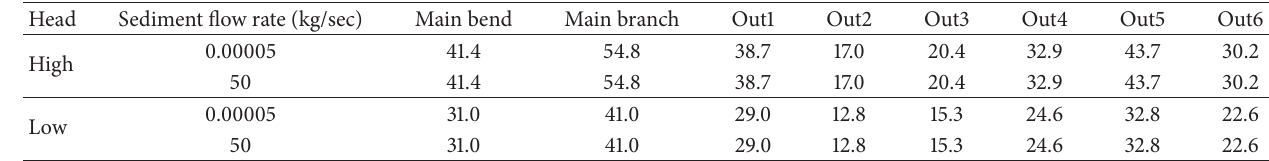
Table 7: Velocity at different locations of Tunnel 2 under different head and varying sediment flow rates.